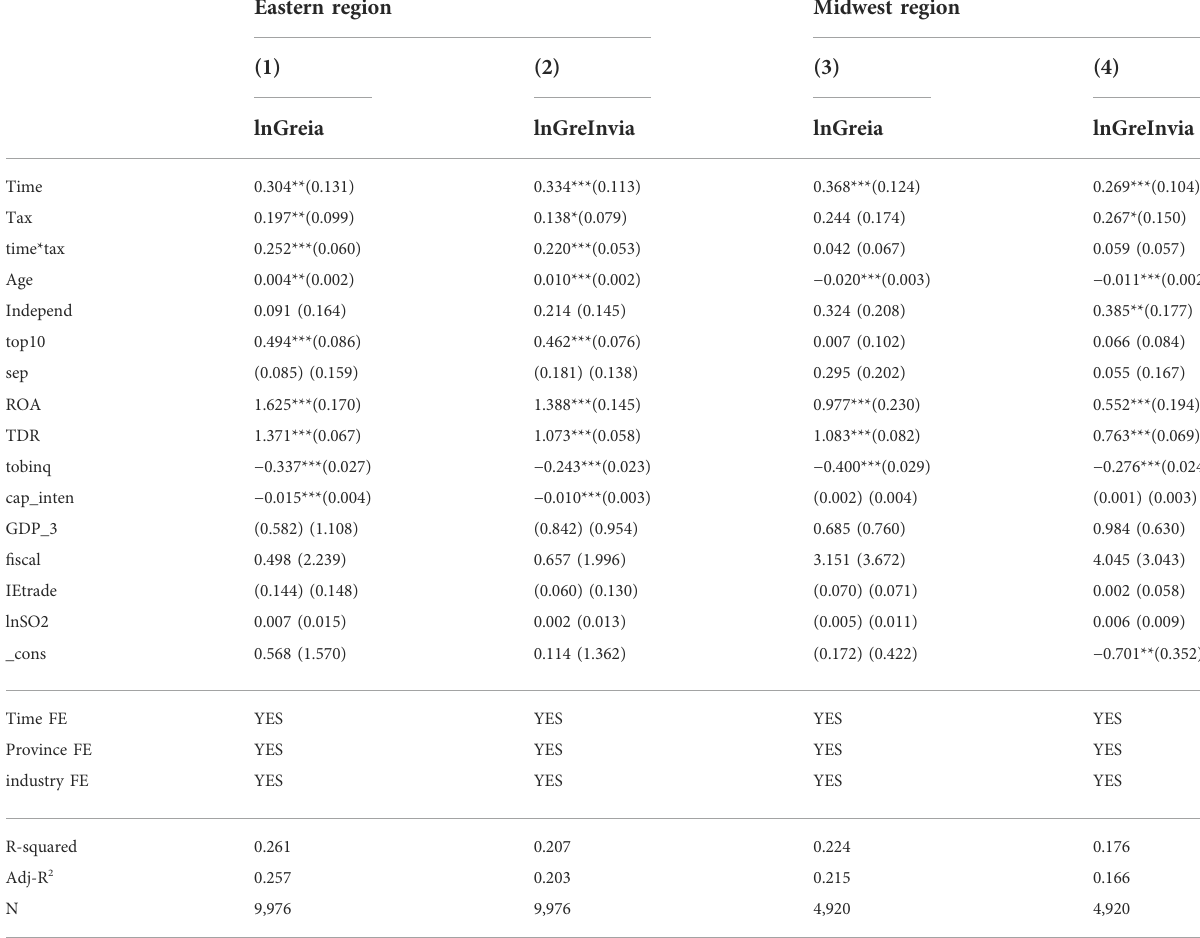
TABLE 7 Regression results by geographical